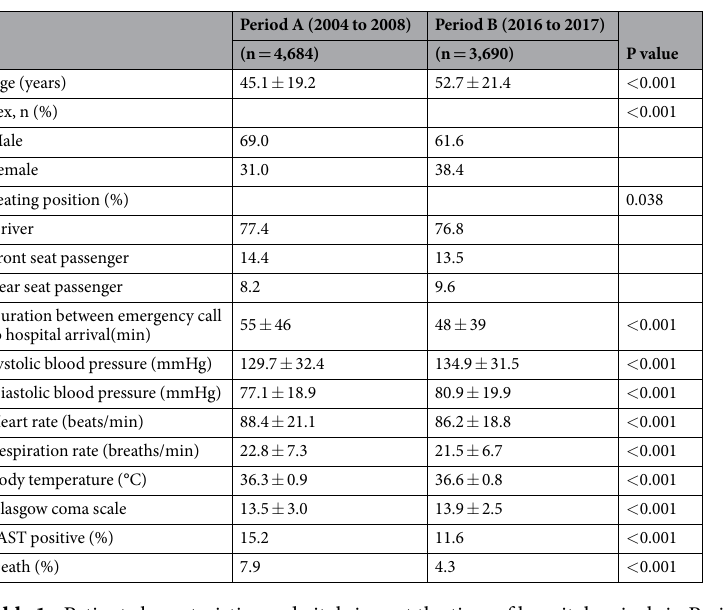
Table 1. Patient characteristics and vital signs at the time of hospital arrivals in Period A versus Period B. FAST: focused assessment with sonography for